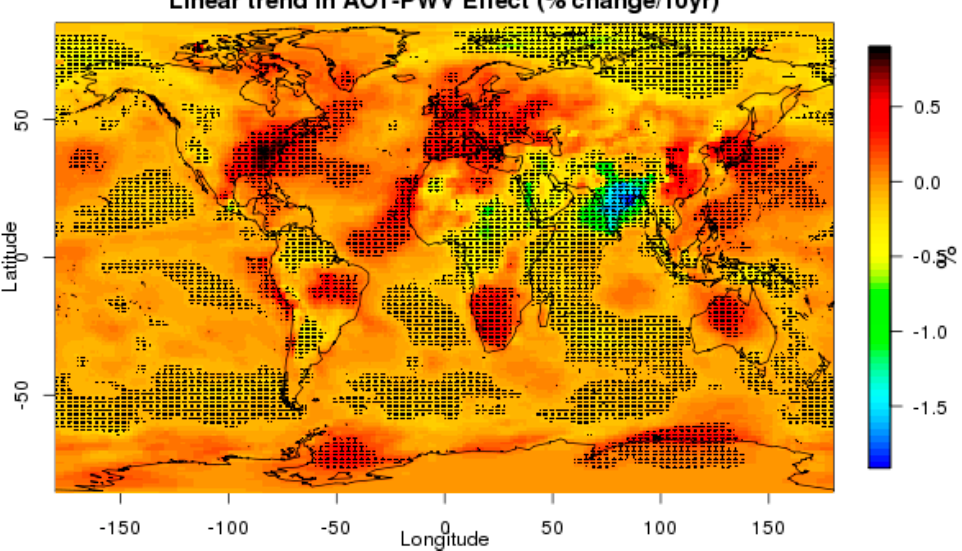
Figure 13. Global spatial distribution of linear trend in AOT-PWV effect per decade. Pixels with levels of significance p < 0.05 are marked with a black dot.